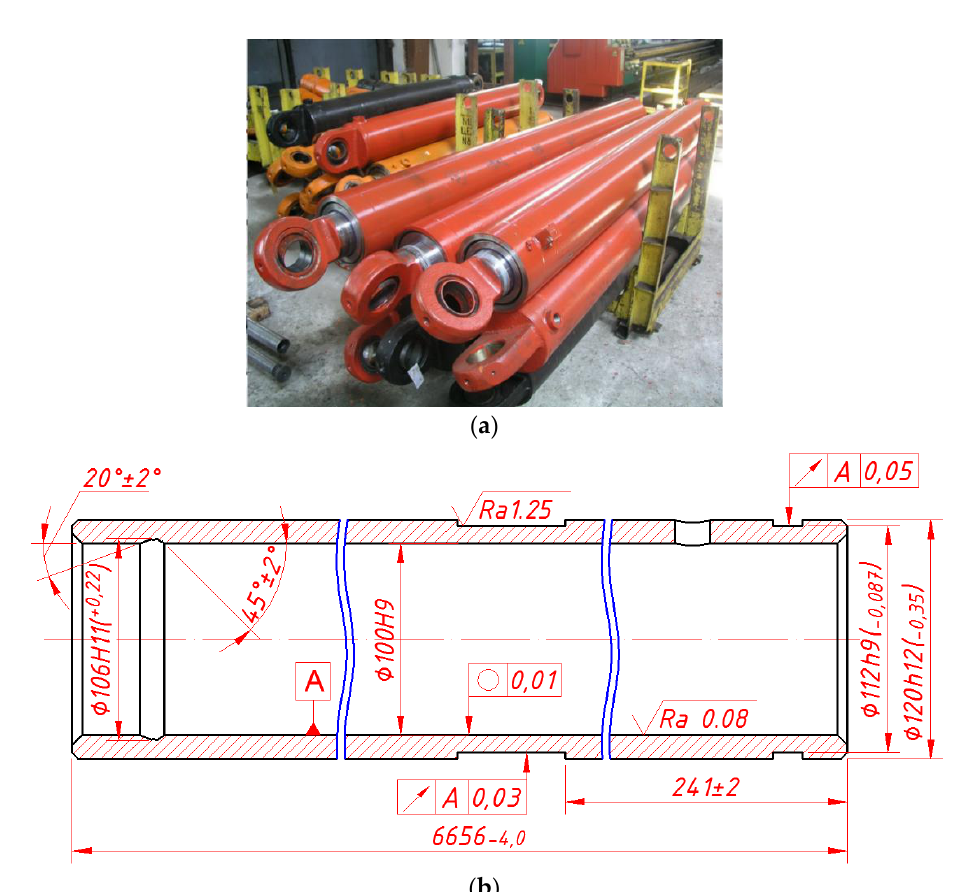
Figure 1. KS-4574.63.900-03.00 plunger hydrocylinder for telescoping the truck crane beam, manufactured at Drohobych Truck Crane Plant ( a ) and some technical requirements for its cylinder liner ( b ). The geometric parameters of the hydrocylinder are presented in Table 2.